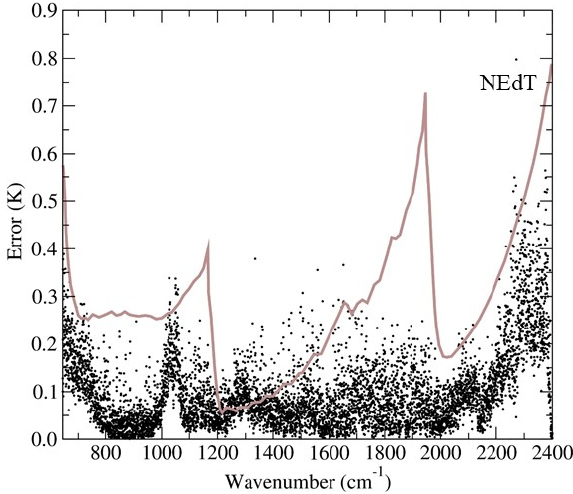
Figure 1. The root mean square of the TOA brightness temperature for the IASI 7021 channels (645–2400cm − 1 ) between line-by-line and MBCRM calculations. The satellite zenith angle 0 ◦ and surface emissivity 1.0 were applied, and the temperature of the atmosphere at surface pressure height was used as surface temperature. The brown line is the NEdT (noise-equivalent brightness temperature) of IASI at 280K (Hilton et al., 2012). The atmospheric profile dataset is available from https://nwp-saf.eumetsat.int/oldsite/deliverables/ rtm/profile_datasets.html (last access: 18 January 2022).